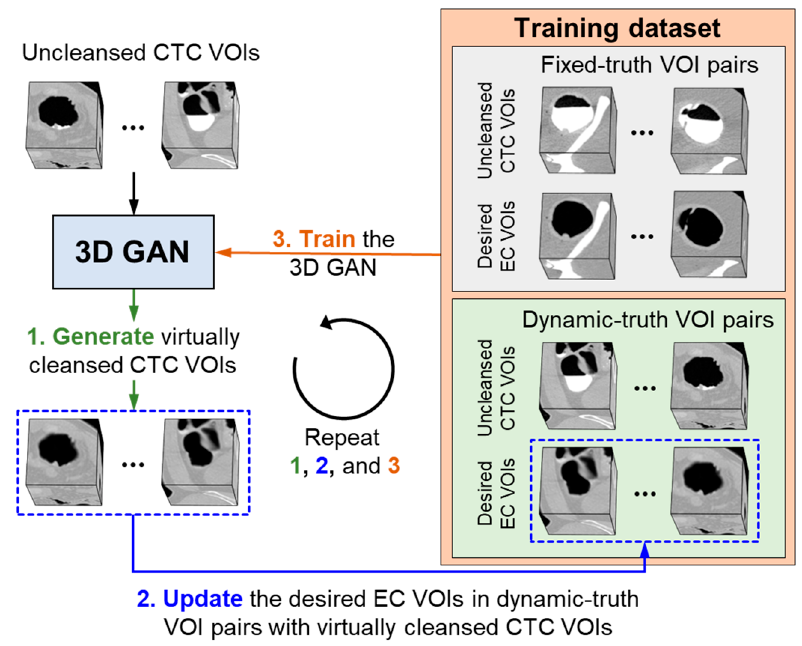
Figure 2. Overview of our proposed self-supervised learning for the training of the 3D-GAN EC scheme. EC